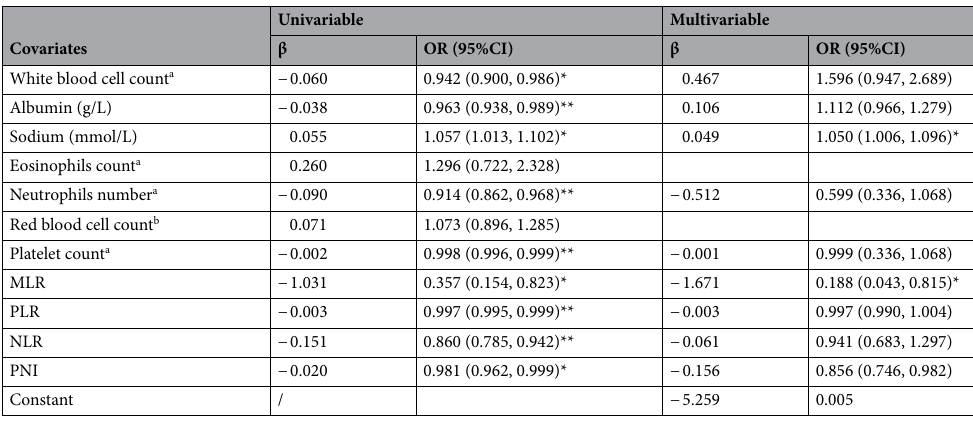
Table 3. Correlation between 11 laboratory variables and QFT-GIT by logistic regression analyses. OR odds ratio; CI confidence interval; MLR monocyte-to-lymphocyte ratio; PLR platelets-to-lymphocyte ratio; NLR neutrophil-to-lymphocyte ratio; PNI prognostic nutritional index. The unit for variables with superscript a was 1000 cells/uL and for variables with superscript b was million cells/ uL. * P < 0.05 and ** P < 0.01.